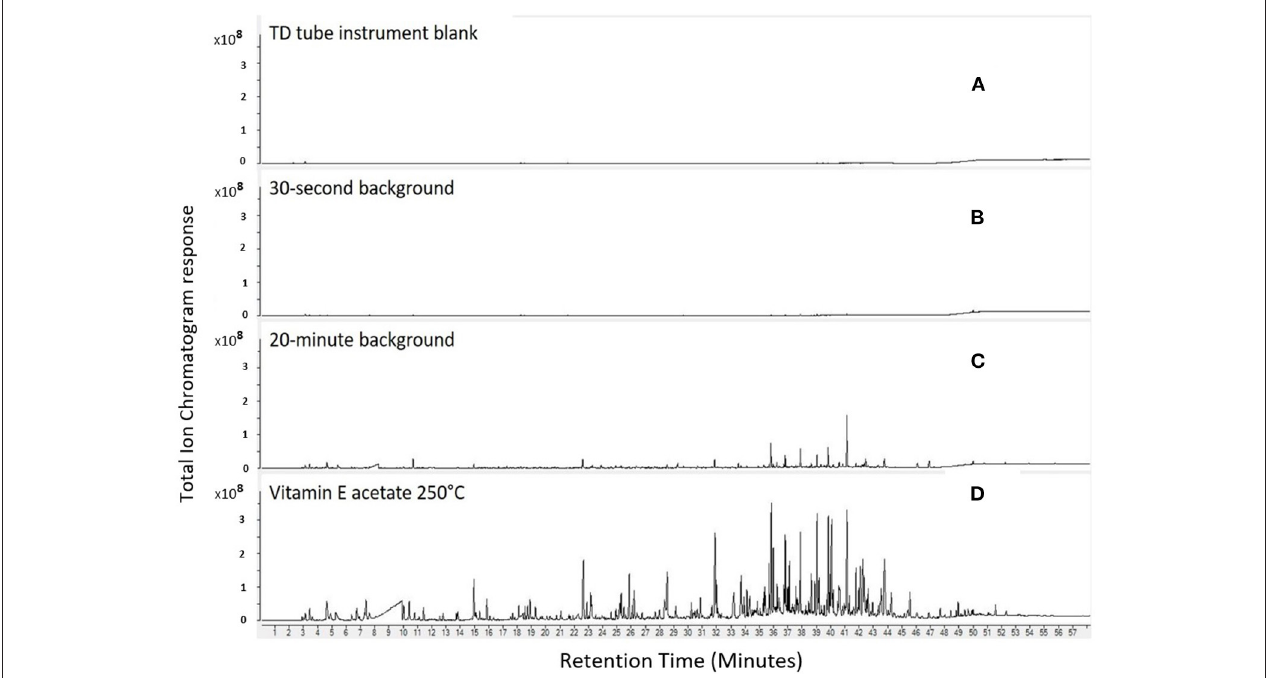
FIGURE 2 | Comparison of TD tube instrument blank (A) , 30-s background (B) , 20-min background (C) , and VEA emissions at 250 ◦ C sampled between 90 and 120s after oil was added to chamber (D) .